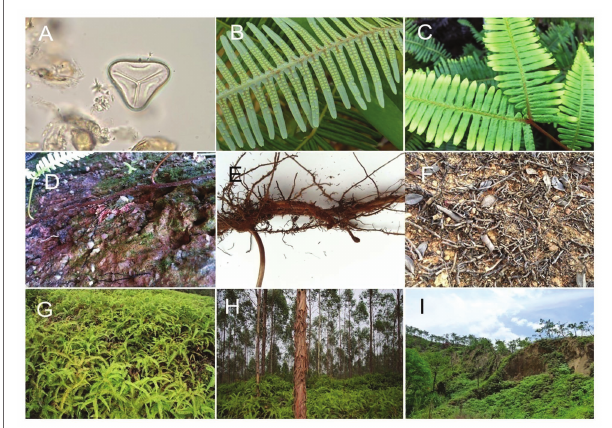
FIGURE 2 | Individuals and communities of Dicranopteris . (A) Spores ×400. (B) Leaf blade and abaxial sporangia. (C) Leaf traits. (D) Underground stems (rhizomes). (E) Underground stems and roots. (F) Post-fire underground stems. (G) A Dicranopteris community on degraded land. (H) Understory Dicranopteris layer. (I) Dicranopteris cover in an area with soil erosion. Photographs were taken in Eucalyptus forests, Pinus forests, or degraded shrubland in subtropical